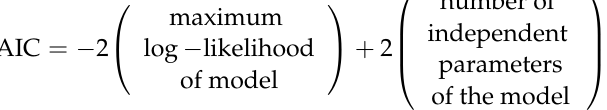
Table 2. Cumulative distribution functions used in the study.